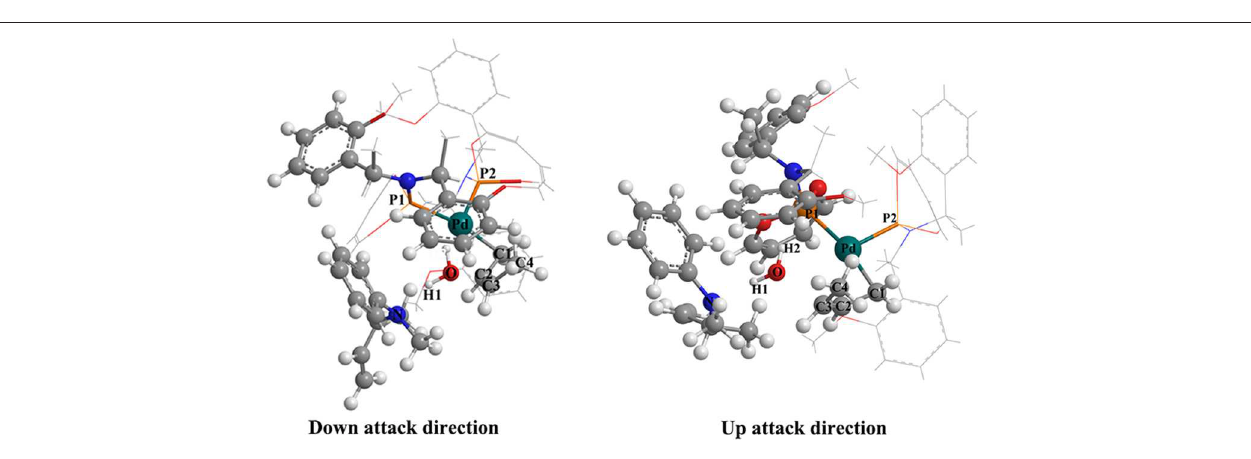
FIGURE 6 | Visualizing the structure of the TSIV-Ib-R state (left picture) and the TSIV-Ib-S state (right picture).